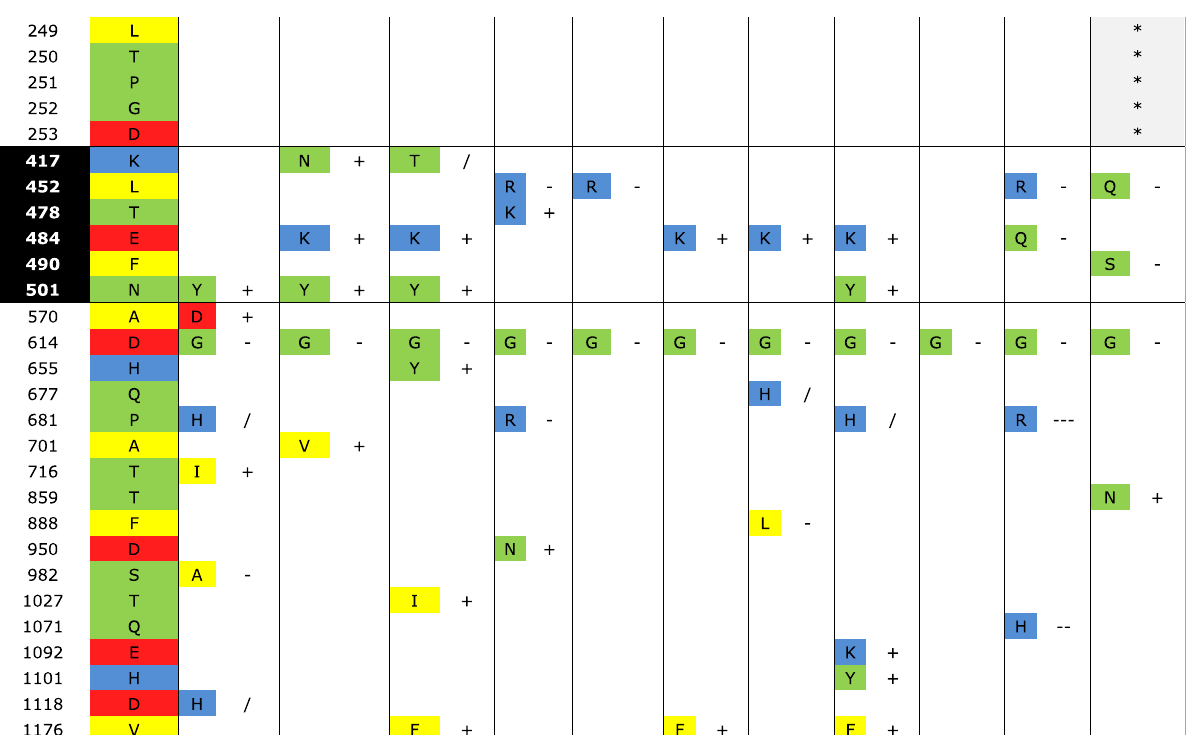
Variants with mutations near by SARS2-S Glycosylation Conserved